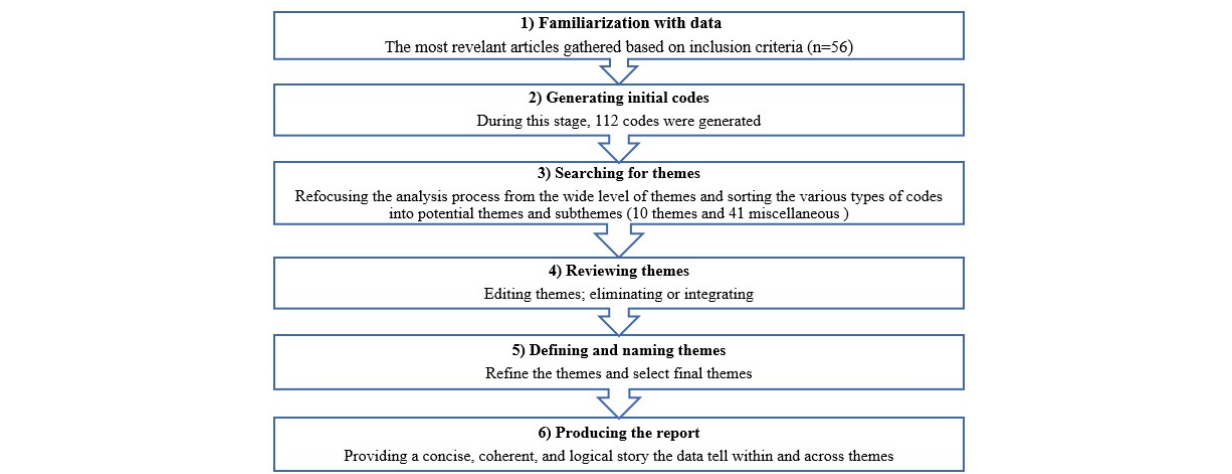
Figure 2. Thematic analysis steps adapted from Braun and